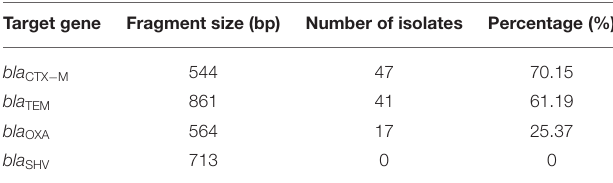
TABLE 5 | The detection rate of ESBLs-encoding genes of 67 pathogenic E. coli isolates.